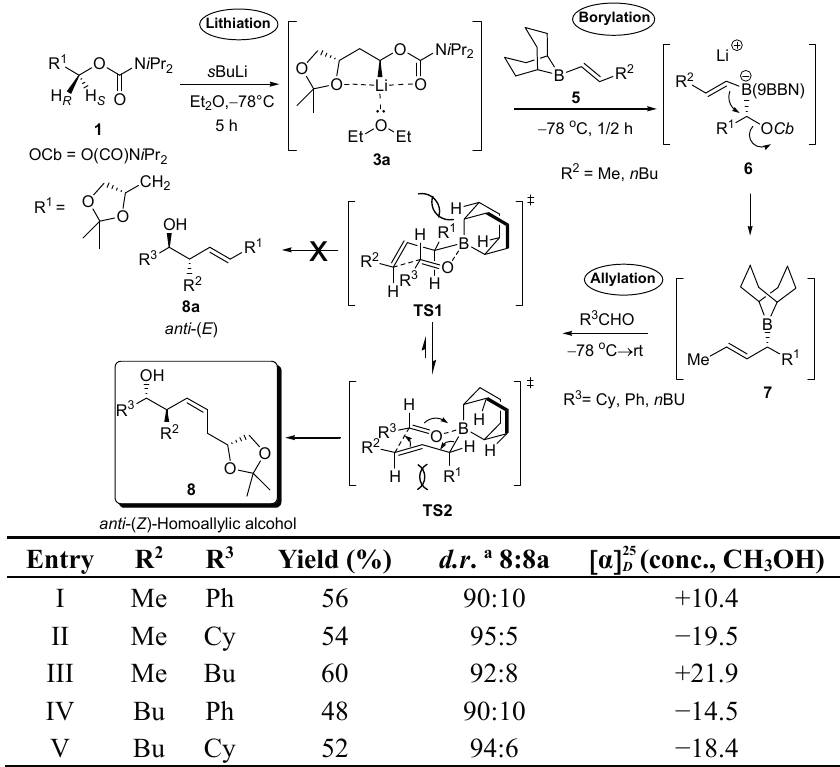
a : Relative Stereochemistry determined by the crude product 1